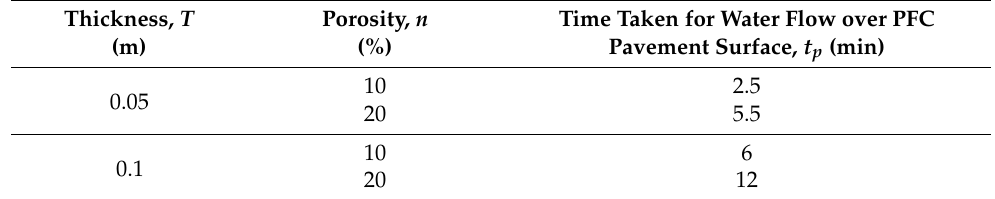
Table 6. Time taken for water flow over the PFC pavement surface ( t p ) for I = 100 mm/h, L R = 10 m, and S R = 2%.